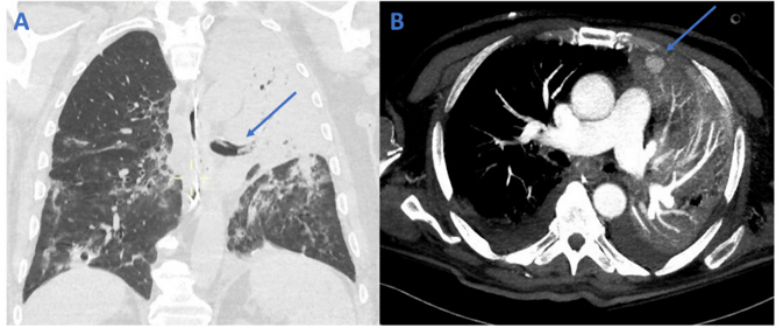
Figure 2. Chest CT scan at emergency department admission. Legend: complete collapse of left upper lobe and lingula and partial collapse of left lower lobe are shown, with main bronchial branches obstructed by clots (arrow in ( A )). A pseudo-aneurysm was also found in the upper anterior left lobe (arrow in ( B )).